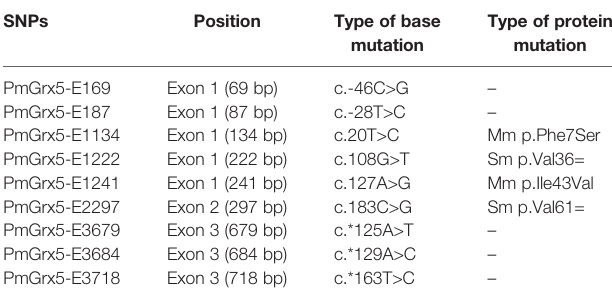
TABLE 2 | Speci fi c information of the SNPs of PmGrx5